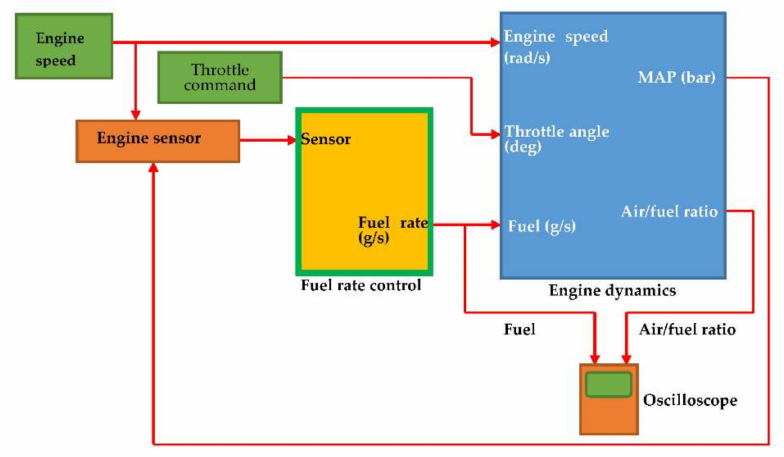
Figure 8. Fuel injection control system.